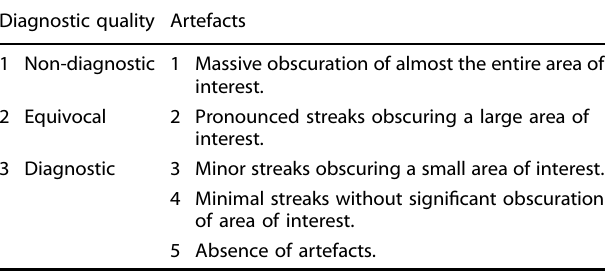
Table 3. Scoring system for the reduction of metal artefacts.